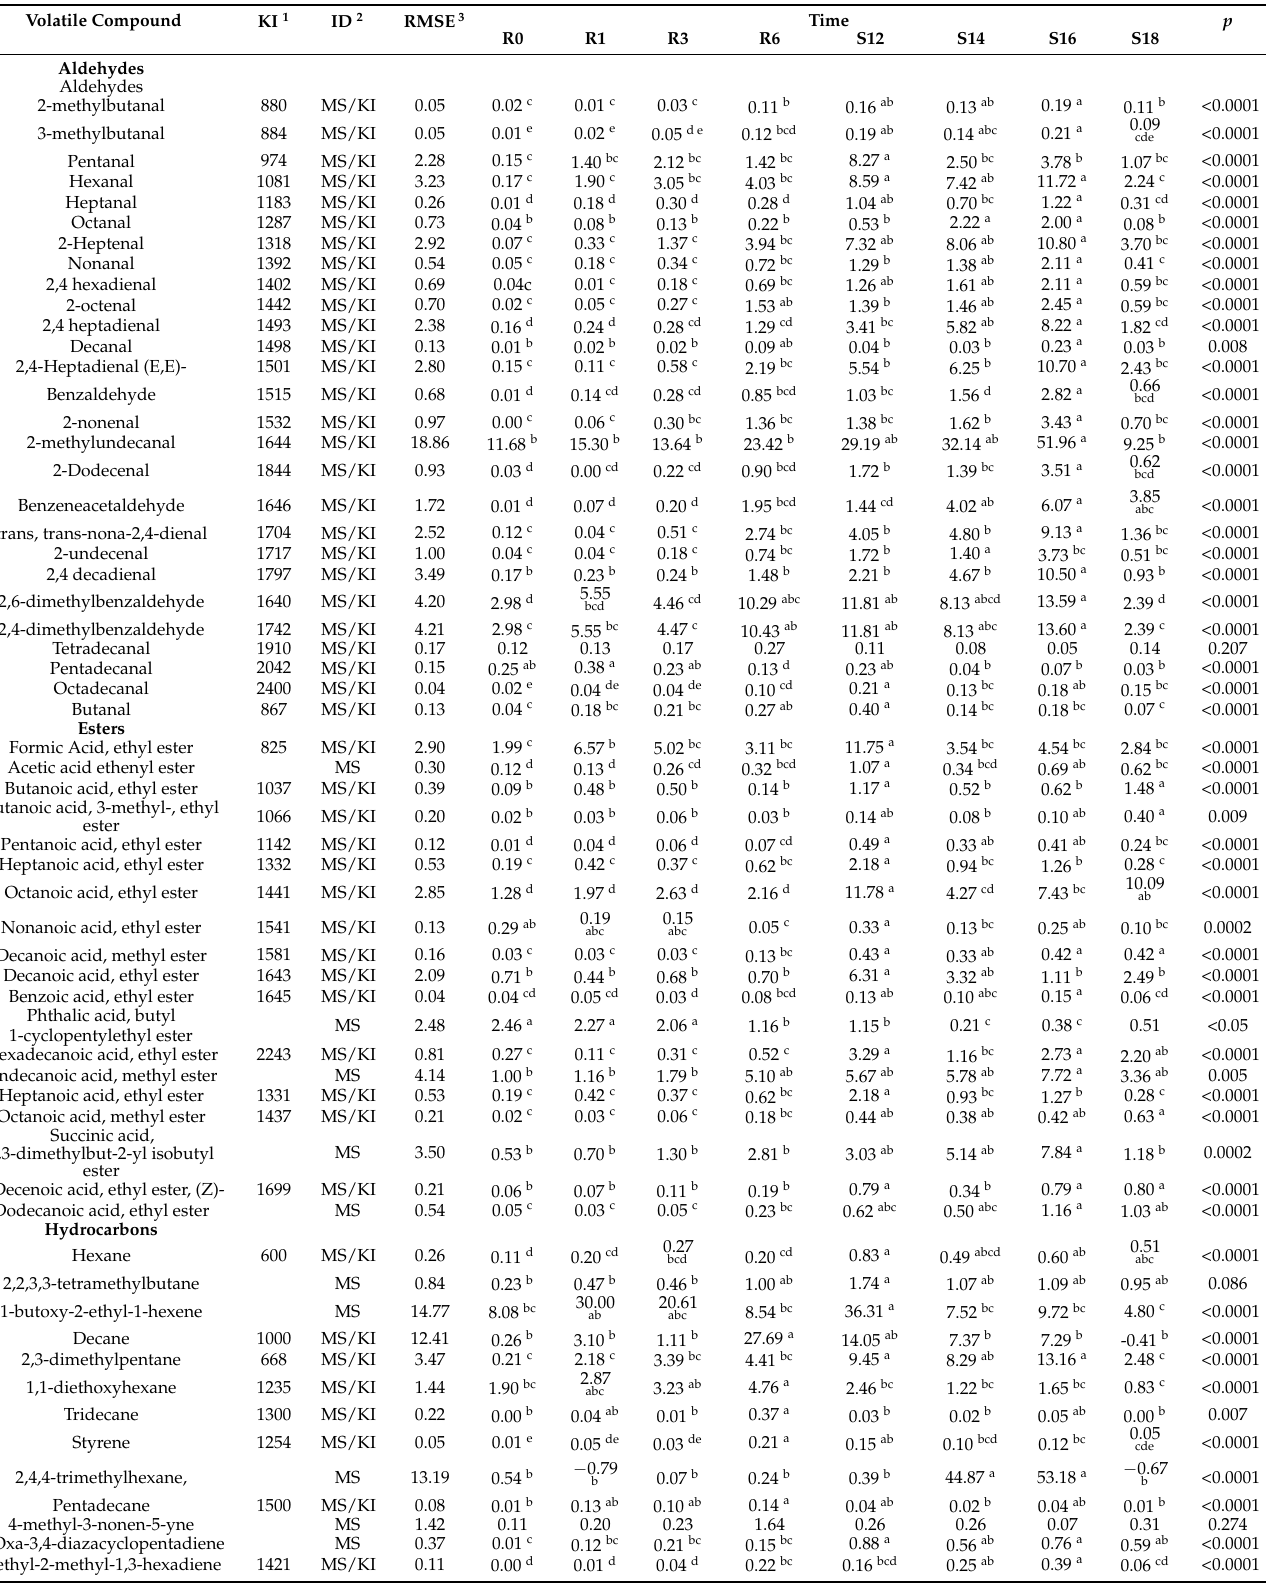
Table 3. Effect of ripening and seasoning times on volatile compounds of subcutaneous fat Toscano dry-cured ham ( n = 10). Volatile